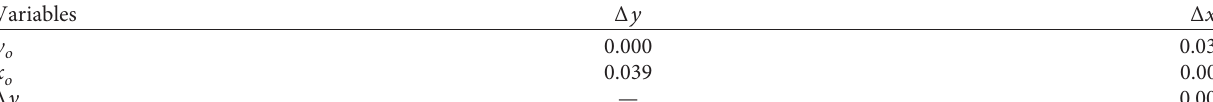
Table 1: The p value of the deviation process with lateral and longitudinal deviations.